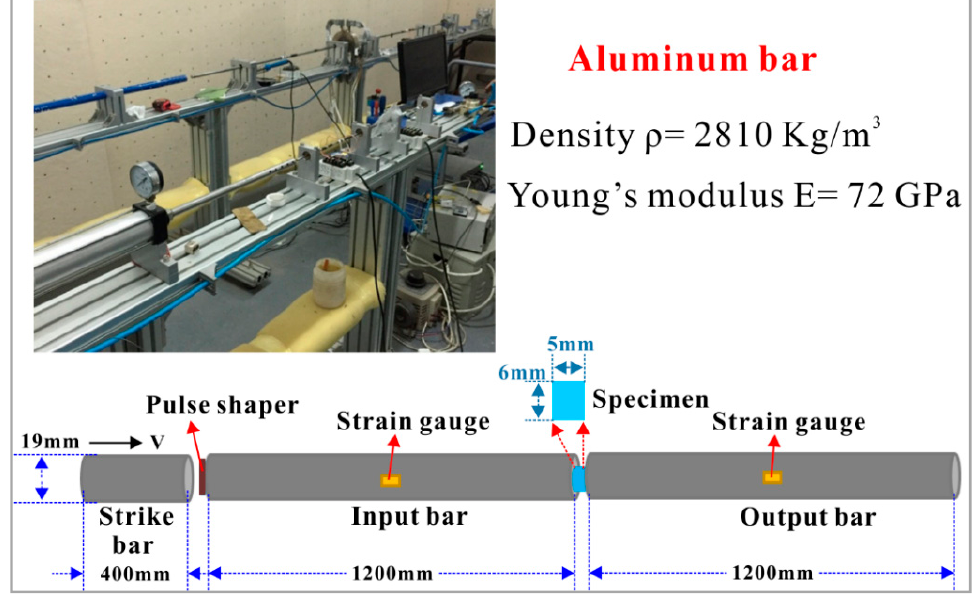
Figure 3. Physical image, schematic diagram, and detailed specifications of the employed split Hopkinson pressure bar (SHPB) device with aluminum bars.